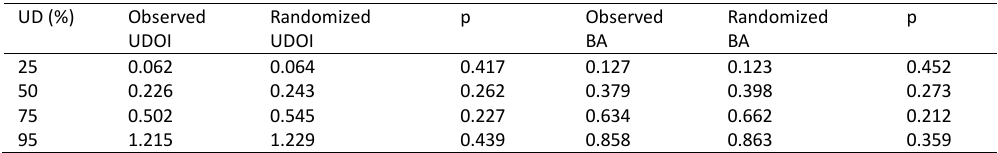
Table 2. Estimated overlap in utilization distributions (UD) between male and female snow petrels from Ile des Pétrels, Adélie Land, East Antarctica. UDOI: Utilization distribution overlap index. BA: